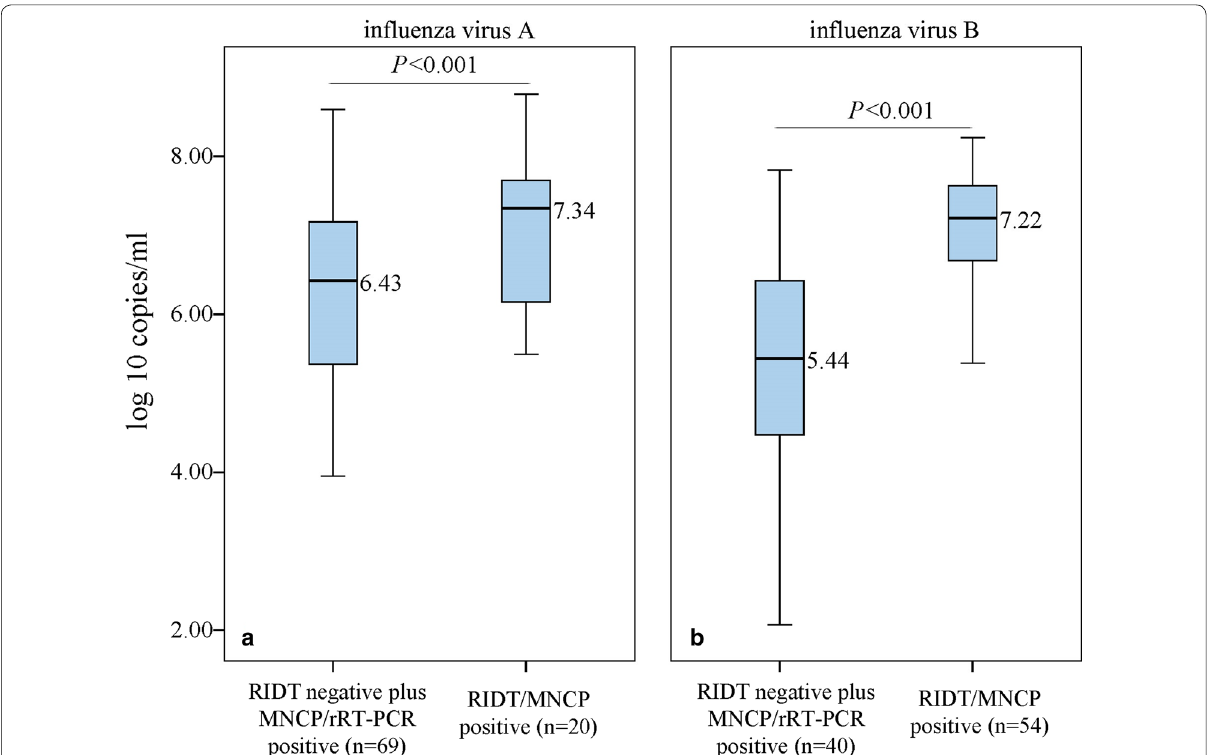
Fig. 4 Box and whisker plots of the viral concentration distribution of samples with RIDT/MNCP positive results and RIDT negative and MNCP/ rRT-PCR positive results determined by rRT-PCR (log 10 copies/ml). a Influenza A virus. b Influenza B virus. The box showed the median (thick line and number) and interquartile range (box length). The whiskers represented 1.5 times interquartile ranges or the highest/lowest points). MNCP: micro/nanofluidic chip platform; RIDT: rapid influenza diagnostic test; rRT-PCR: real-time reverse transcription